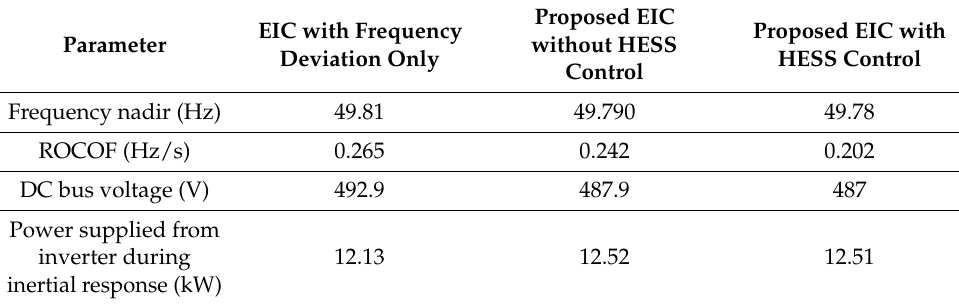
Table 2. Performance comparison of different EIC strategies under sudden load